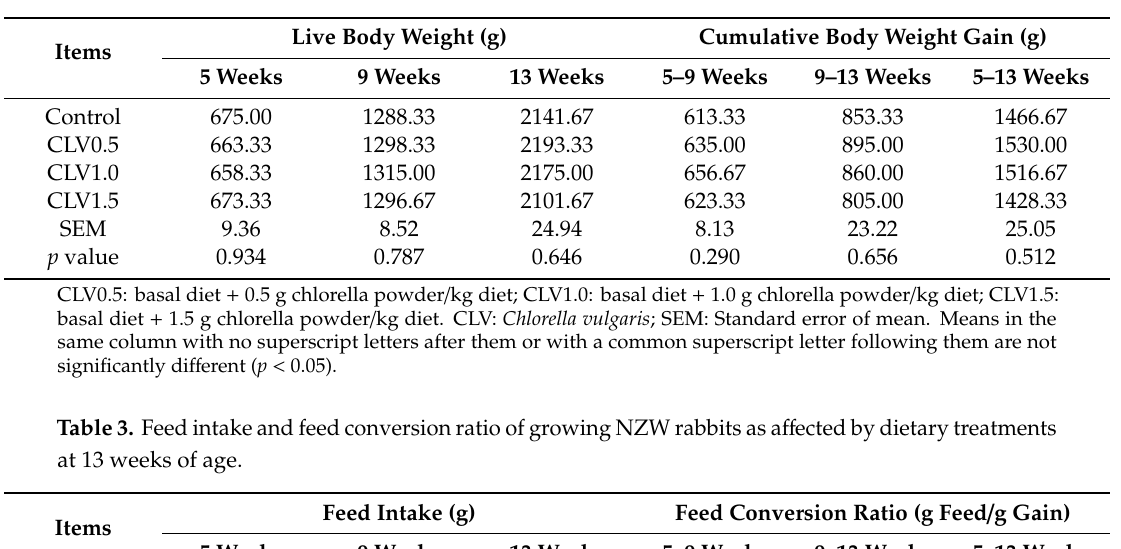
Table 2. Live body weight and body weight gain of growing New Zealand white (NZW) rabbits as a ff ected by dietary treatments at 13 weeks of age.